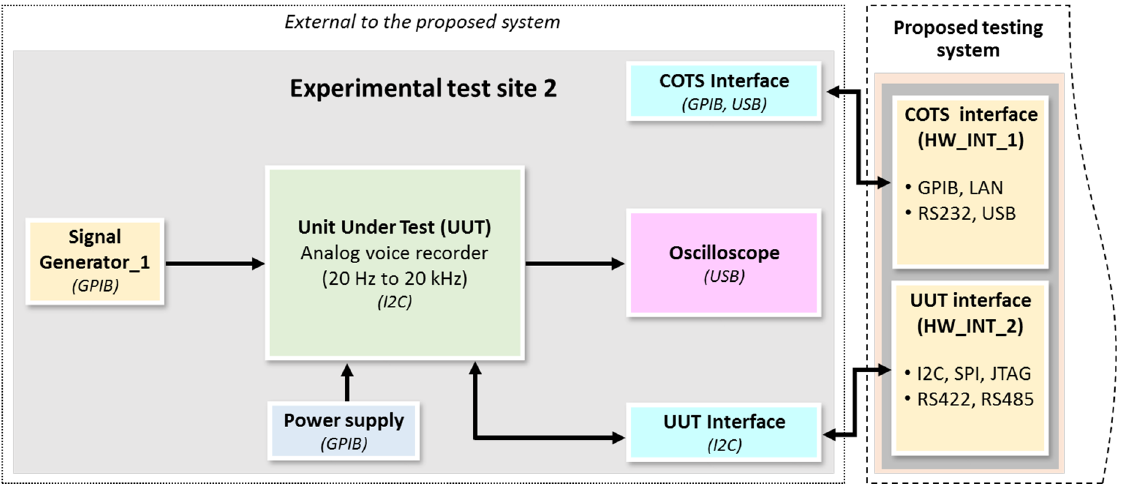
Figure 9. Experimental test site 2 setup.